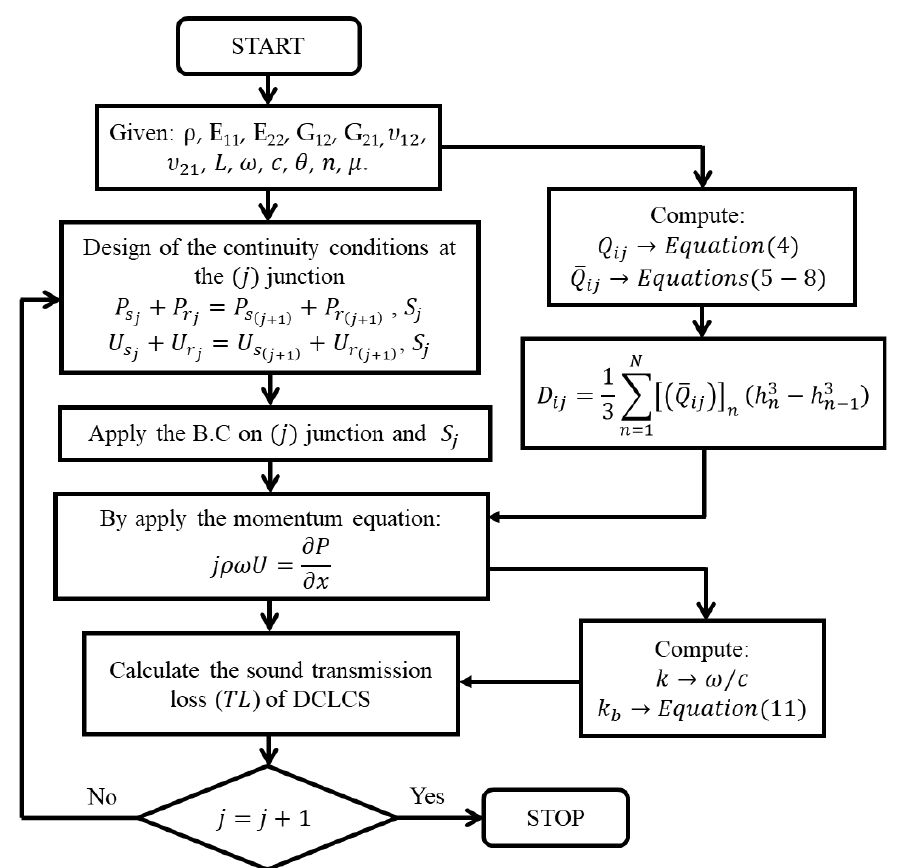
Figure 5. Algorithm of the governing equation solution technique to find the muffler TL.